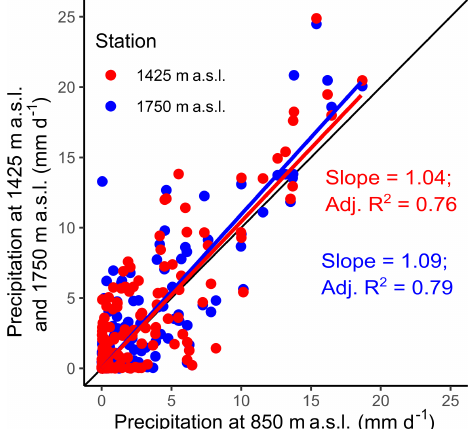
Figure 4. Correlations between daily precipitation at 1425ma.s.l. (red) and 1750ma.s.l. (blue) with daily precipitation at 850ma.s.l. Lines are least squares regressions. Also shown in black is the 1 : 1